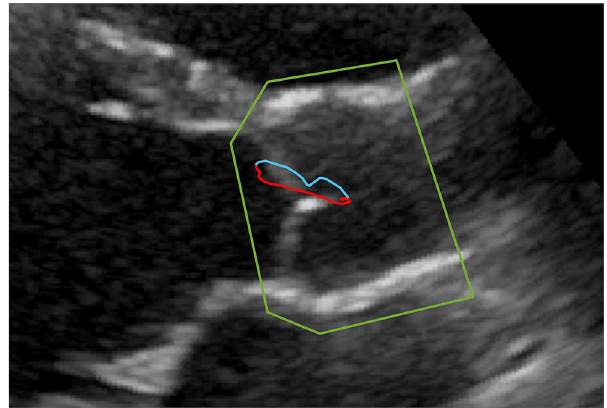
Figure 2. Close-up of the aortic root with its systolic and diastolic motion paths marked with a red and blue lines, respectively, and the region of interest (ROI) marked with a green